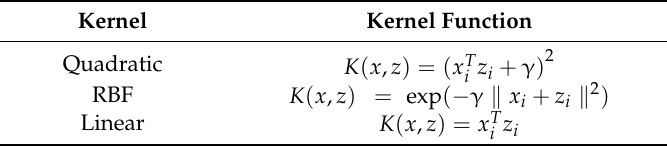
Table 2. Support vector machine (SVM) kernels and its commonly used